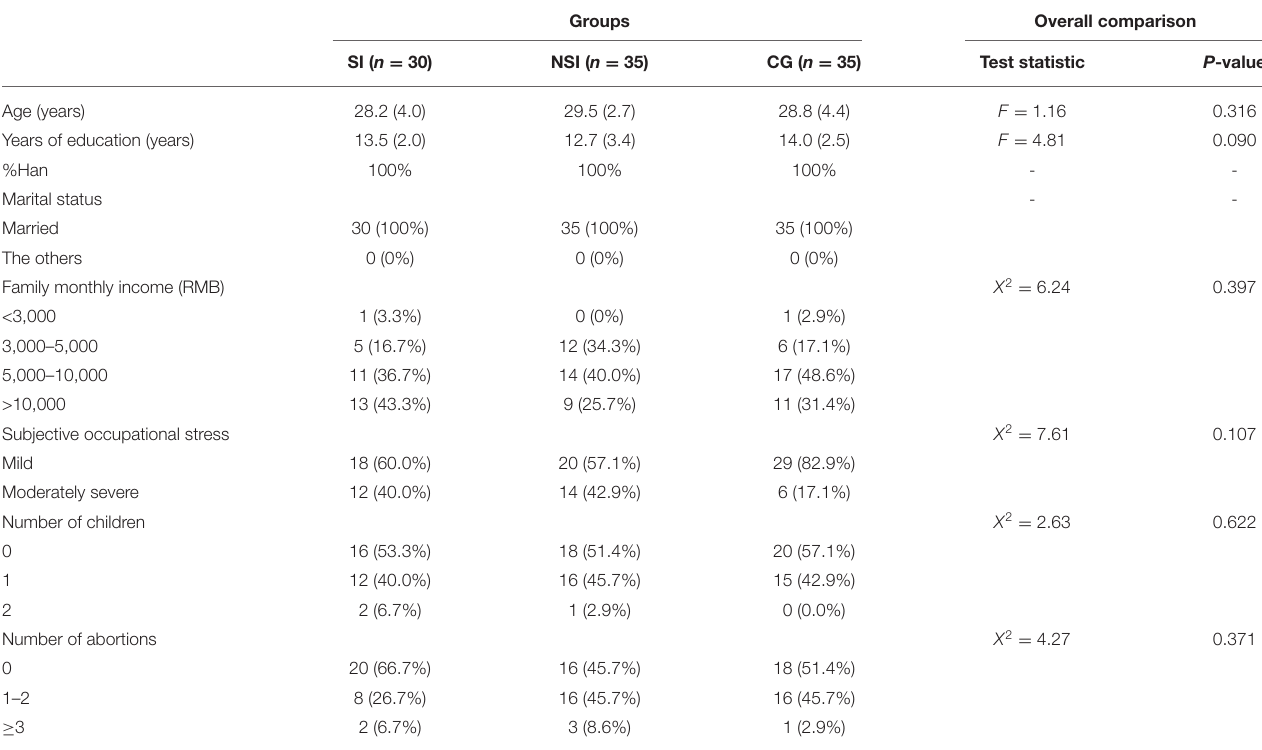
TABLE 1 | Sociodemographic and clinical variables.